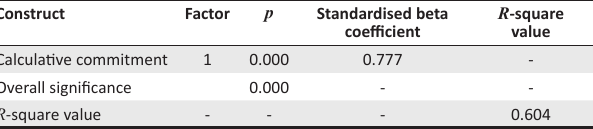
TABLE 10: Influence of calculative commitment on the dependent variable (customer loyalty). Construct